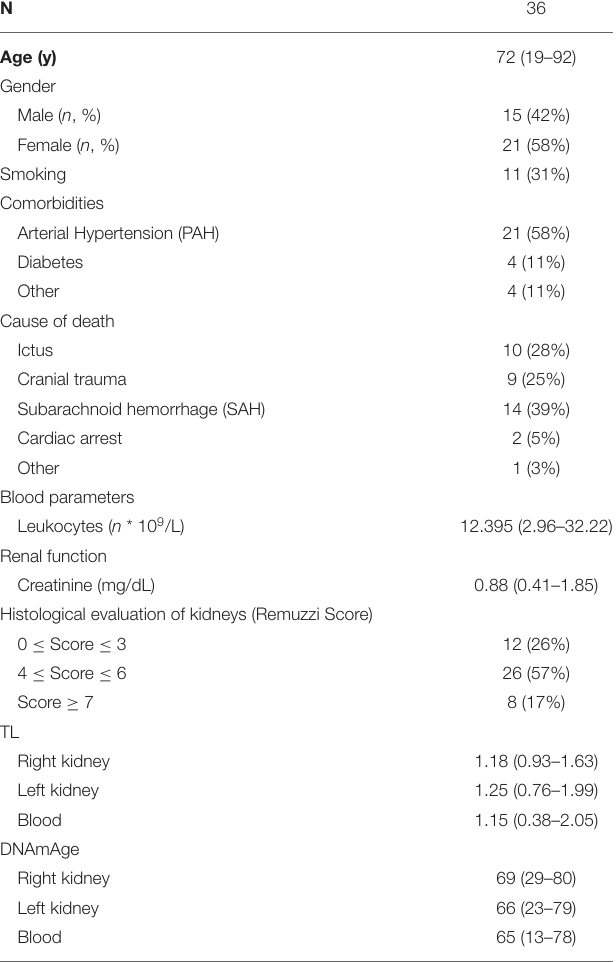
In Figure 1 , DNAmAge of the right (RK) ( n = 27 paired RK vs blood DNAmAge donors (B), paired t -test: median 69 years vs. median 65 years; p = 0.0271) and left kidney (LK) ( n = 27 paired LK vs blood DNAmAge donors (C), paired t -test: median 69 years vs. median 65 years; p = 0.0245) are significantly older than blood leukocytes DNAmAge. RK and LK DNAmAge are similar